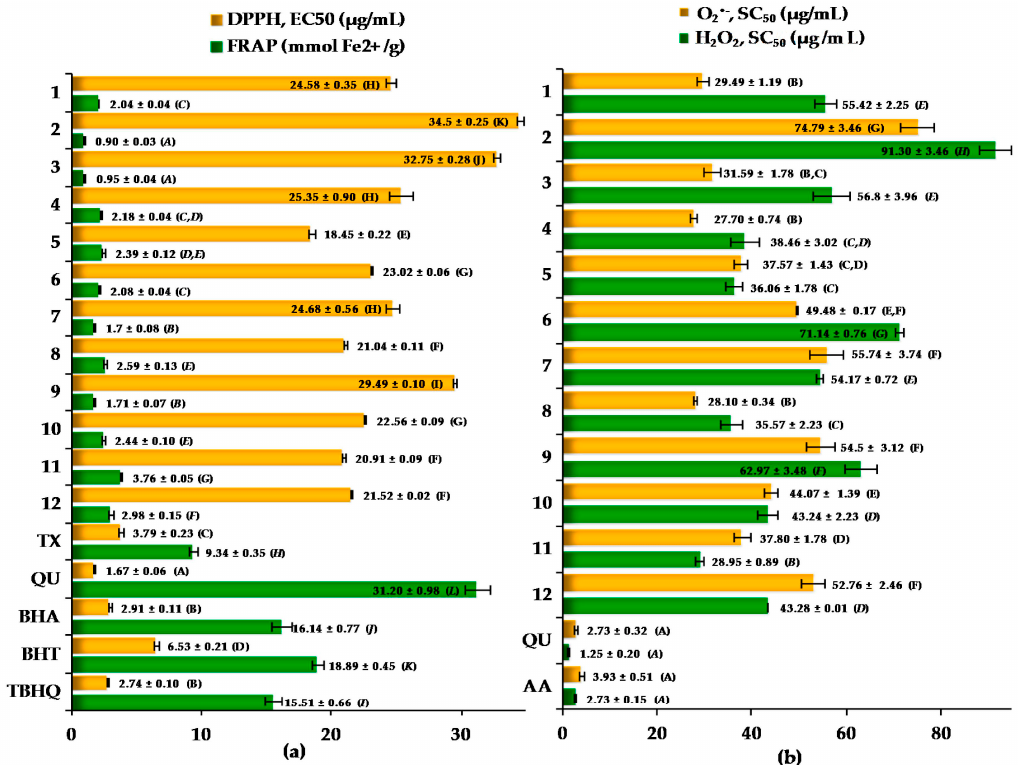
Figure 3. Antioxidant activity of the Cotoneaster leaf extracts and standard antioxidants in: ( a ) the DPPH and FRAP tests; and ( b ) O 2• − and H 2 O 2 scavenging tests. Results are presented as the mean values ± SD ( n = 3); for each activity parameter different capital letters (A–G and A–L) indicate significant differences at p < 0.05 by Tukey’s test; scavenging ability (EC 50 and SC 50 ), the amount of the plant samples or the standards required for 50% reduction of initial ROS concentration; FRAP, ferric reducing antioxidant power expressed in mmol Fe 2+ per g of the dry leaves or the reference compounds; for the species codification see Table 1; reference standards: TX, Trolox ® ; QU, quercetin; AA, ascorbic acid; BHA, butylated hydroxyanisole; BHT, 2,6-di- tert -butyl-4-methylphenol; TBHQ, tert -butyl-hydroquinone.